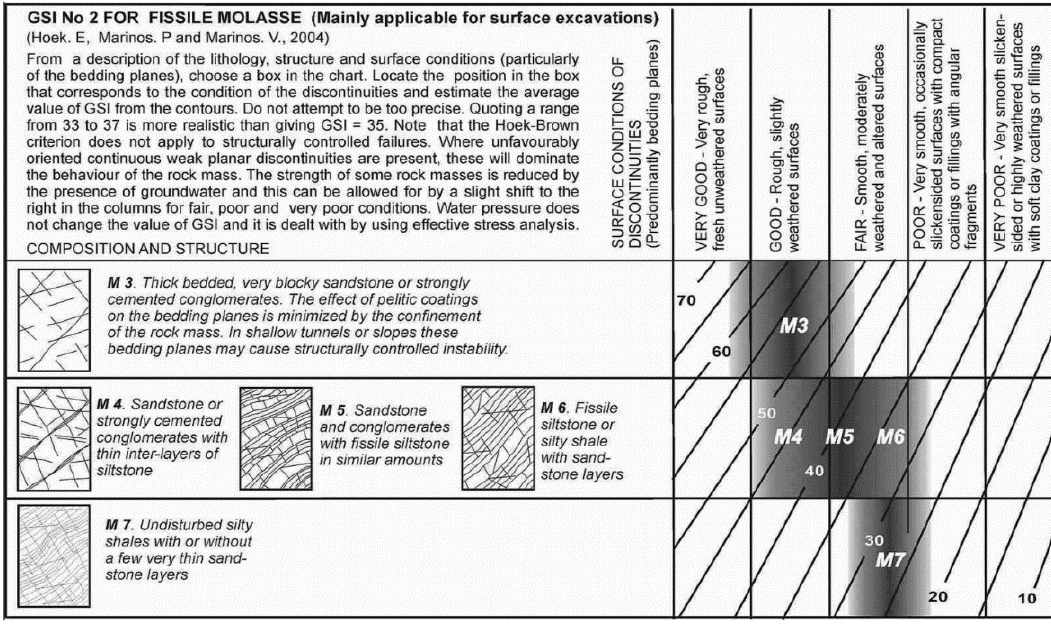
Figure A8. GSI chart for other rock masses [26].